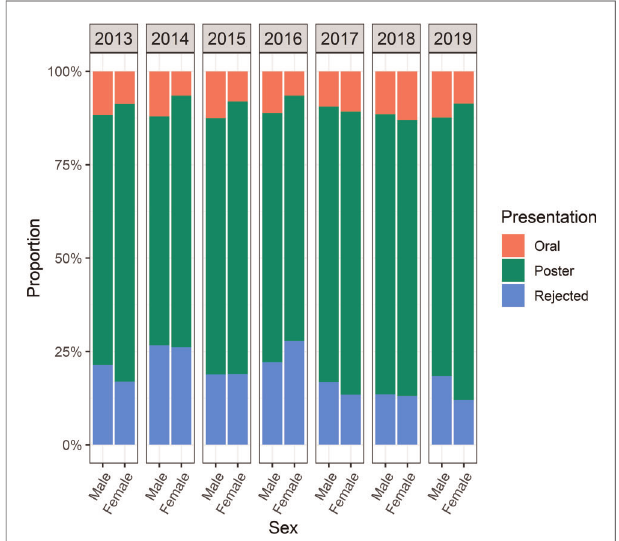
FIGURE 4 | Comparison of abstracts submitted to AMCG annual meeting from 2013 to 2019 by sex and status of acceptance (oral, poster, or rejection).